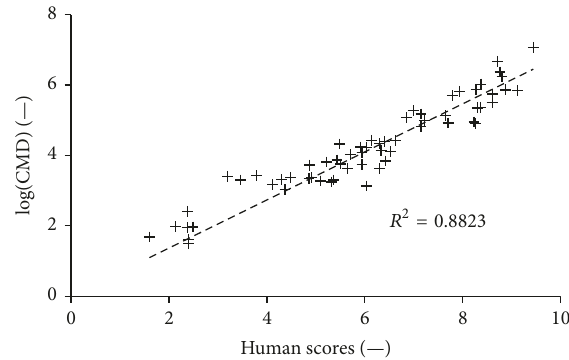
Figure 1: The correlation of the human scores and the software scores in the case of a 35-pixel window